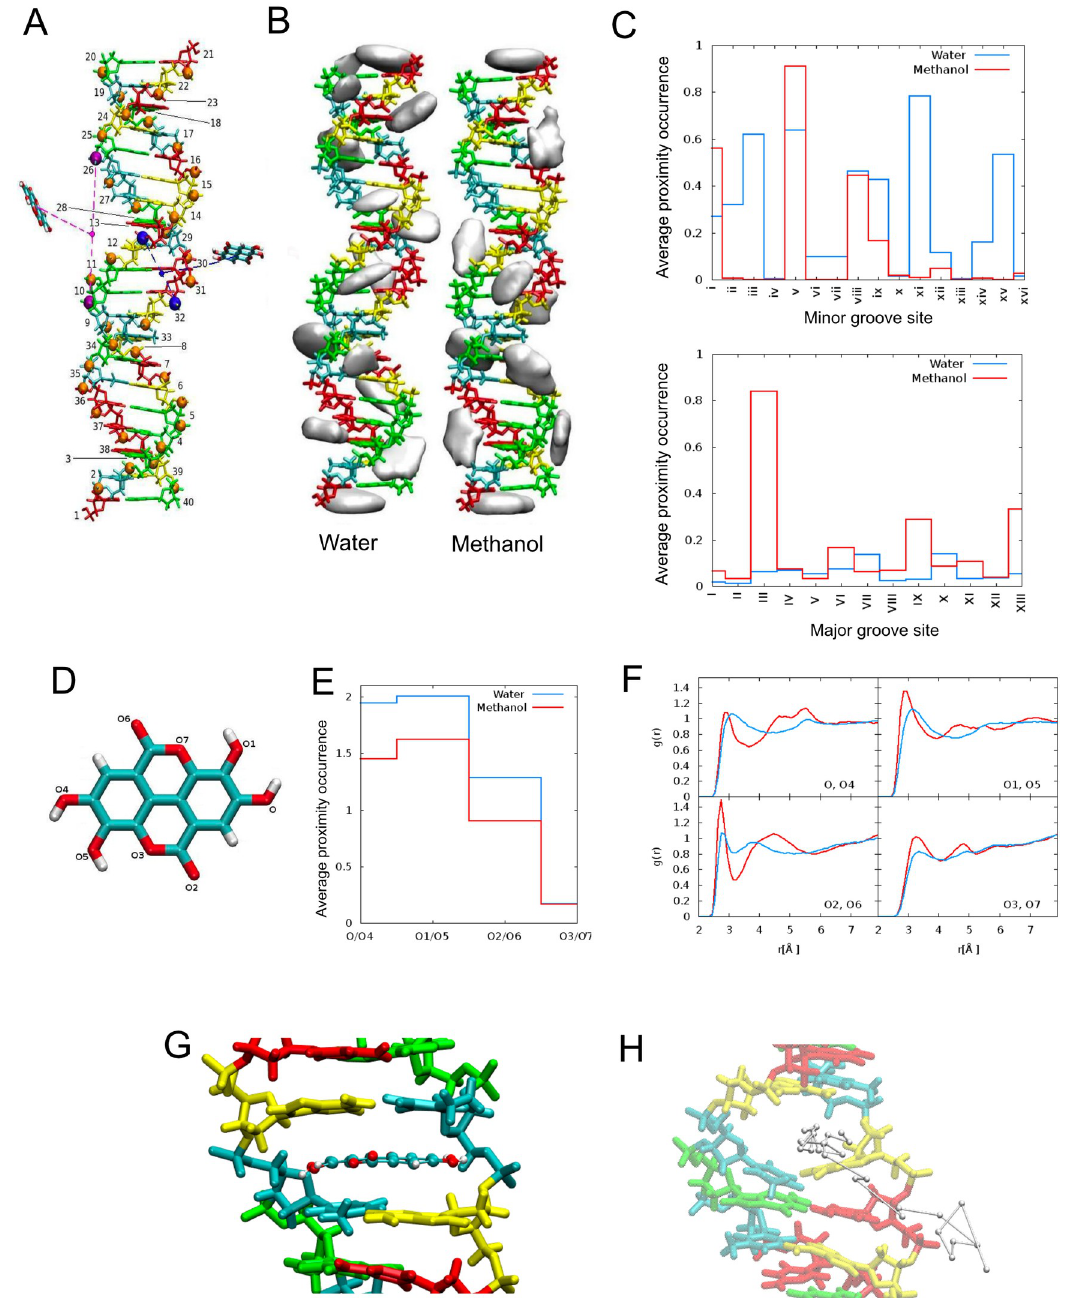
Fig 2. Interactions between ellagic acid, solvents and DNA. A) dsDNA model with labels (1 to 40) for the nucleobases. Cytosine is in red, adenine in yellow, thymine in cyan, guanine in green, and phosphorus atoms in orange. An exemplar minor-groove site (viii) is shown in blue and an exemplar major-groove site (IX) is shown in purple, with the relevant distances for the proximity calculation of ellagic acid. B) Density maps of ellagic acid atoms in interaction with dsDNA in water and in methanol. The isosurfaces correspond to a density of 0.5 Å − 3 . C) Average proximity occurrences in the minor groove sites (top) and in the major groove sites (bottom). D) Ellagic acid with labelled oxygens. E) Average number of hydrogen bonds between ellagic acid oxygens and water (blue) and methanol (red) oxygens, averaged for each pair of equivalent ellagic acid oxygens. F) Pair correlation function ( g ( r )) of ellagic acid oxygens and water (blue) and methanol (red) oxygens, averaged for each pair of equivalent ellagic acid oxygens as labelled in the ellagic acid model. G) A representative molecular dynamics snapshot of the intercalated ellagic acid within DNA bases. H) An example of ellagic acid unbinding trajectory obtained with metadynamics. This image was made with VMD and is owned by the Theoretical and Computational Biophysics Group, NIH Center for Macromolecular Modeling and Bioinformatics, at the Beckman Institute, the University of Illinois at Urbana-Champaign (www.ks.uiuc.edu). https://doi.org/10.1371/journal.pone.0254971.g002 PLOS ONE | https://doi.org/10.1371/journal.pone.0254971 November18,